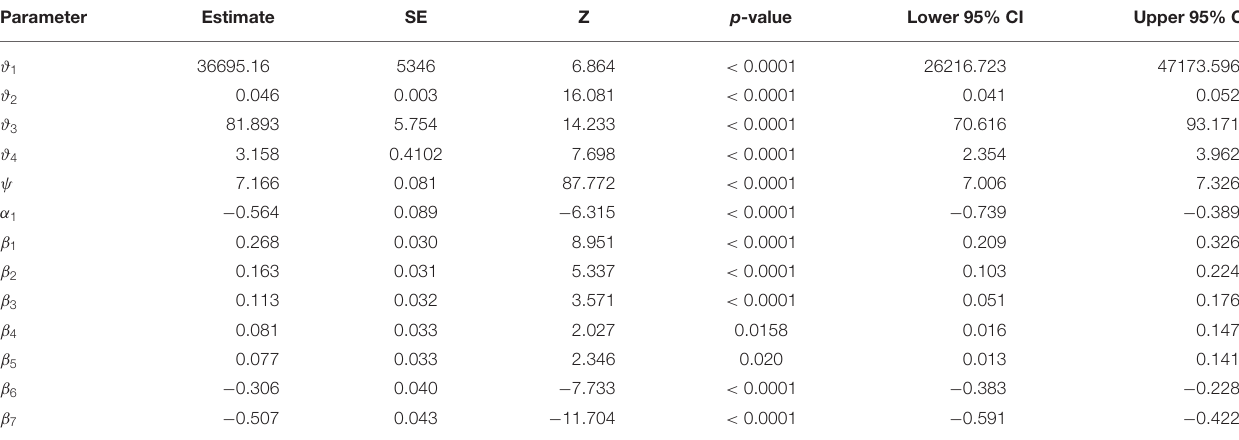
TABLE 1 | Summary of estimated parameters. Parameter